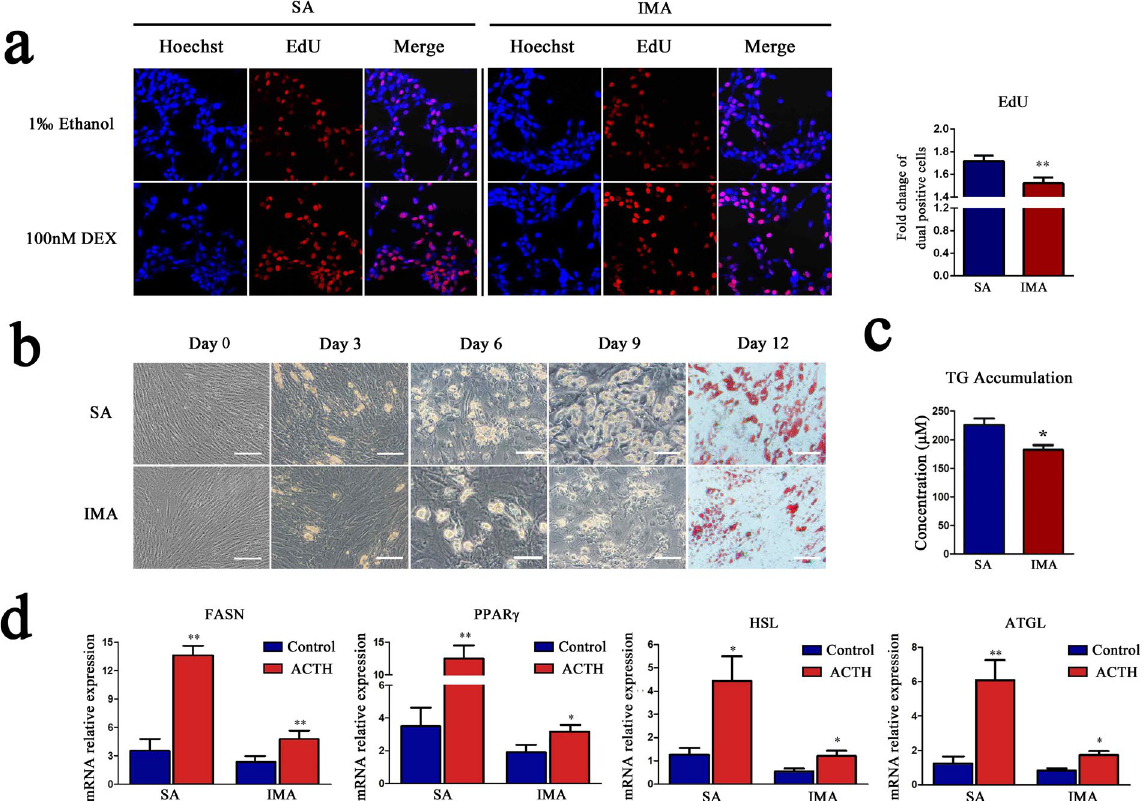
Figure 1. IMA was less sensitive to GCs than SA. ( a ) The EdU assay of SA and IMA pre-adipocytes. The porcine SA and IMA pre-adipocytes were treated with 1‰ ethanol or 100 nM DEX for 3 days, then the proliferating nuclei were stained red with EdU, the nuclei of all cells were stained blue with Hoechst for 2 hours. Three random pictures per group from confocal microscopy were used to count the cell numbers of EdU positive cells and Hoechst positive cells, and the ratio of the EdU positive cells to Hoechst positive cells was calculated in each picture. Data are shown as the mean ± SEM, n = 3 per group, * P < 0.05. ( b ) The differentiation of SA and IMA pre-adipocytes after induced with DEX. Cells were induced to differentiation by 2.5 μ M DEX, and imaged by inverted microscope. Scale bar = 100 μ m. ( c ) Triglyceride accumulation in SA and IMA treated as ( b ) was detected on day 9. Data are shown as the mean ± SEM, n = 3 per group, * P < 0.05. ( d ) mRNA expression of lipid metabolism genes in SA and IMA tissues of sows injected with 1 U/kg ACTH (n = 6) or equivalent volume saline (n = 6) intravenously per day for a total 9 days were detected. * Means significant differences between control and ACTH groups, * P < 0.05, ** P <